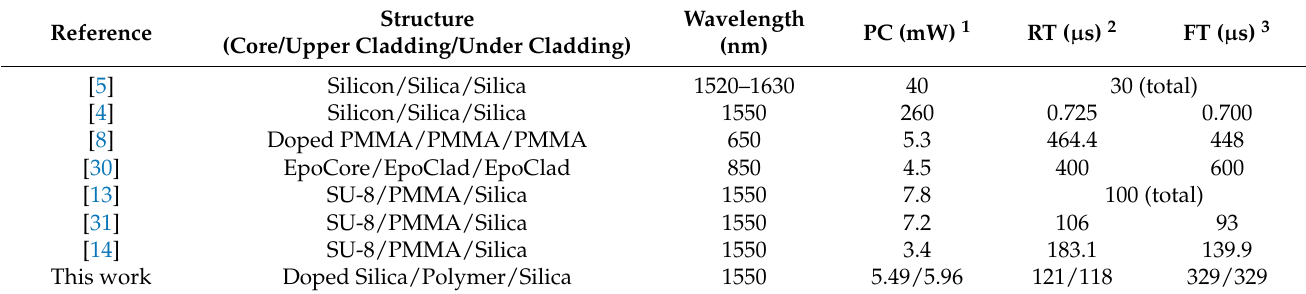
Table 1. Comparisons among the performances of this thermal optical switch and those of other reported thermal optical